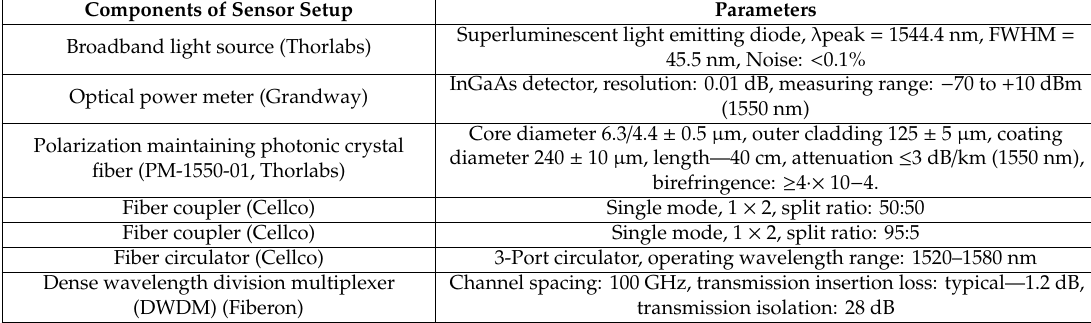
Table 1. The parameters of used components .